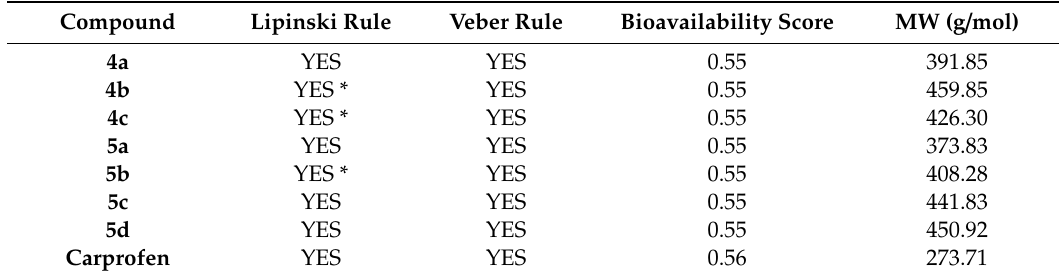
Table 4. Lipinski and Veber rules validation, bioavailability score and predicted molecular weight (MW).